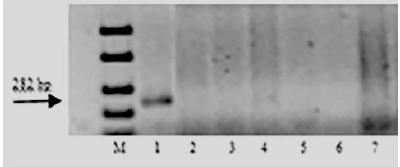
Figure 3. Amplification products of SCAR marker PS10 linked to leaf rust resistance gene Lr47 : M – 100 bp DNA Ladder; 1 — Pavon Lr47 ; 2 — k-62492 T. boeoticum ; 3 — k-66369 T. boeoticum ; 4 — k-64777 T. urartu ; 5 — k-64782 T. urartu; 6 — k-64783 T. urartu; and 7 — k-66372 T. araraticum. Fifteen samples of T. dicoccoides , T. boeoticum , and T. araraticum were resistant to the population of Bgt sampled in the Northwest region of the Russian Federation (Table 4).